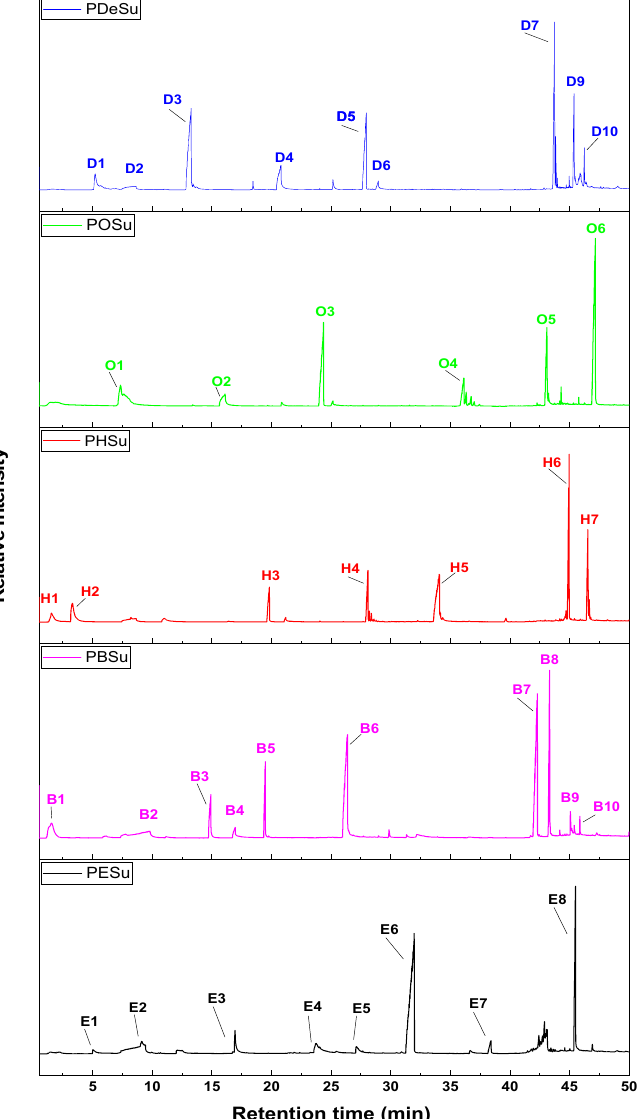
Figure 2. Total ion chromatograms (TICs) of PESu, PBSu, PHSu, POSu, and PDeSu prepared polyesters, pyrolyzed at 450 °C.